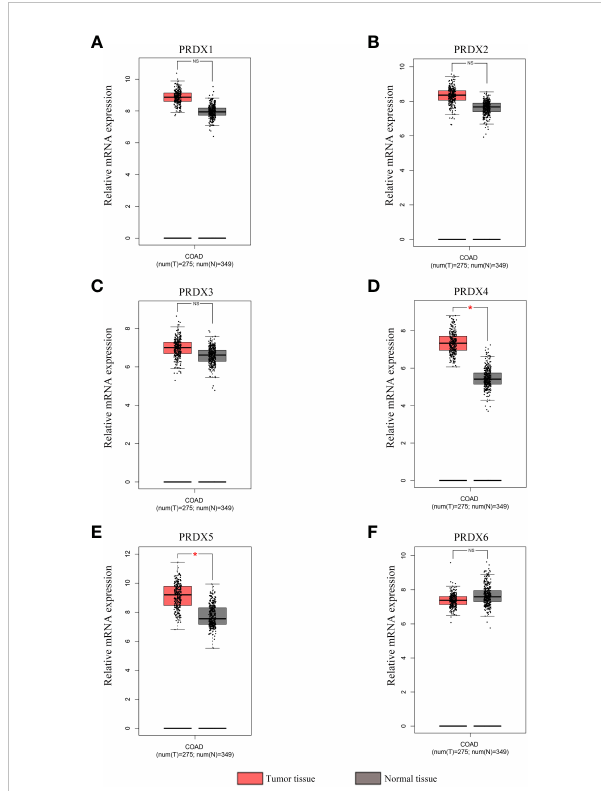
FIGURE 2 Expression analysis of PRDX family members in COAD and normal tissues (GEPIA). (A-F) The mRNA expression levels of each PRDX family member in COAD and corresponding normal tissues were compared in the box plot. * P < 0.05. NS, no signi fi cance; COAD, colon adenocarcinoma.